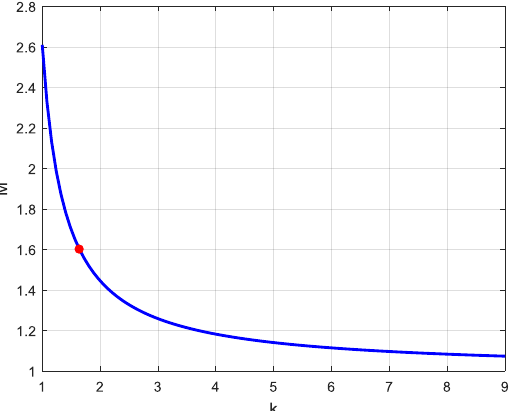
Figure 6. Simplified time-domain gain curves of different k values in PO mode.